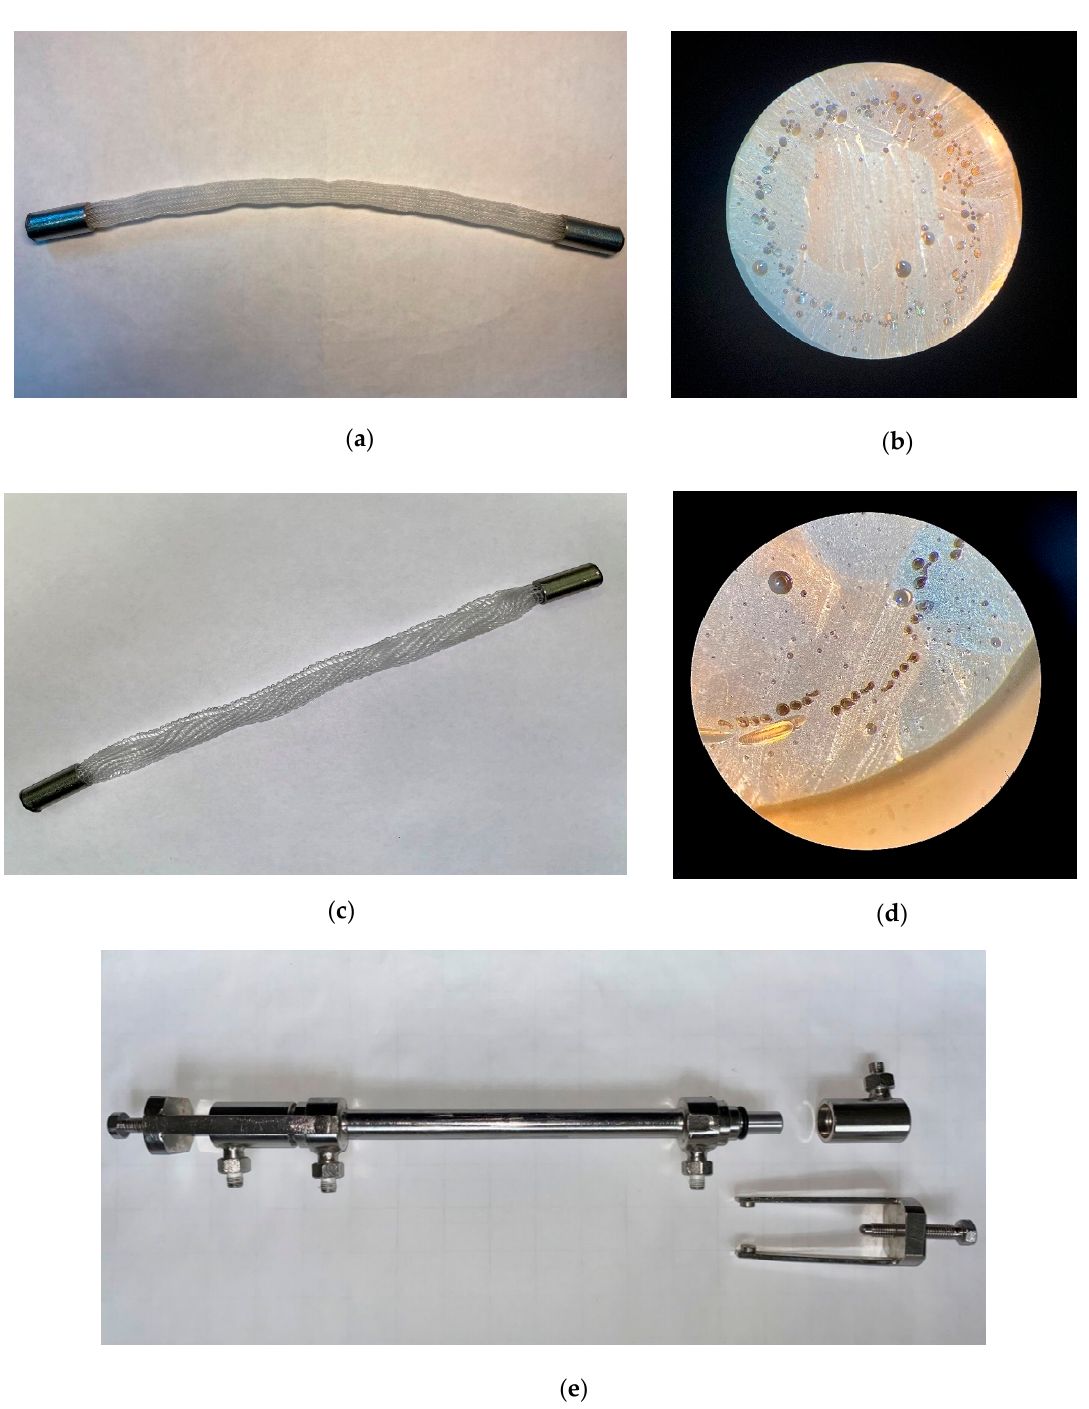
Figure 5. Lab-scale membrane module: ( a ) sealed 3D triaxial braided hose; ( b ) cross-section of the bore-side sealed entrance part; ( c ) sealed woven fabric (rolled); ( d ) cross-section of the bore-side sealed entrance part; ( e ) complete assembly of lab-scale membrane HF module.